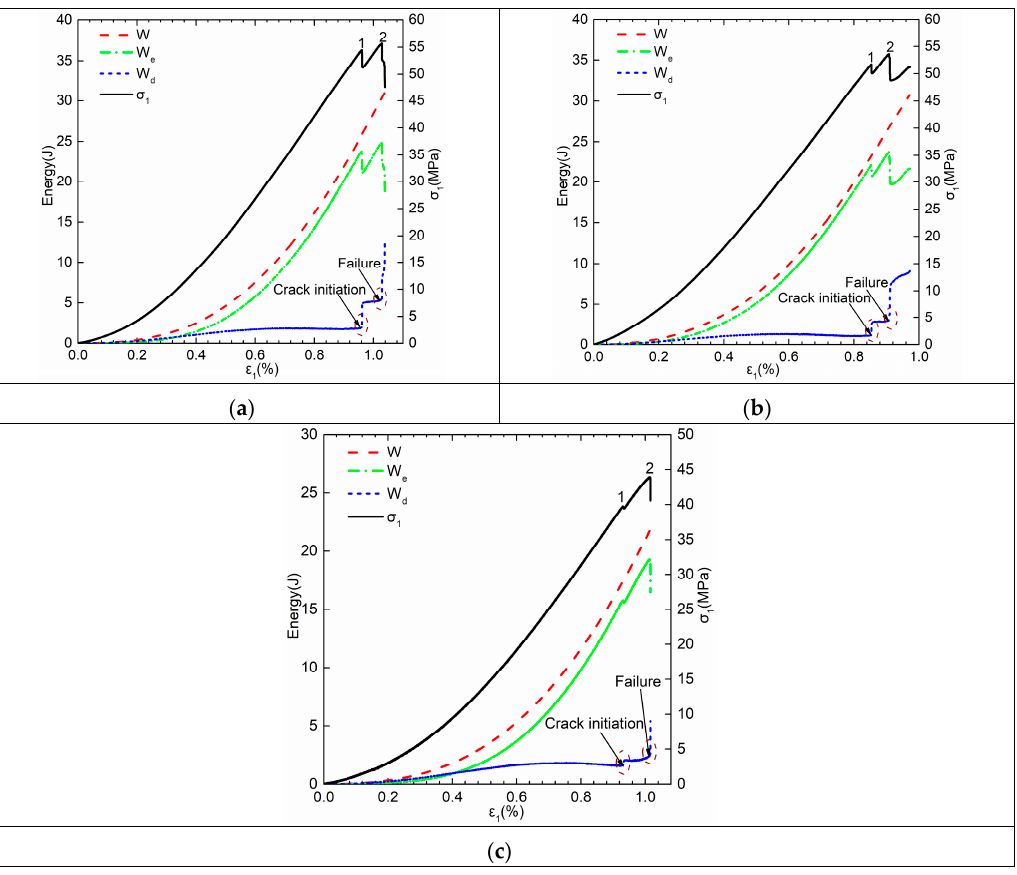
Figure 6. Energy dissipation characteristic curves of specimens containing en echelon flaws: ( a ) B-30; ( b ) B-45; ( c ) B-60.